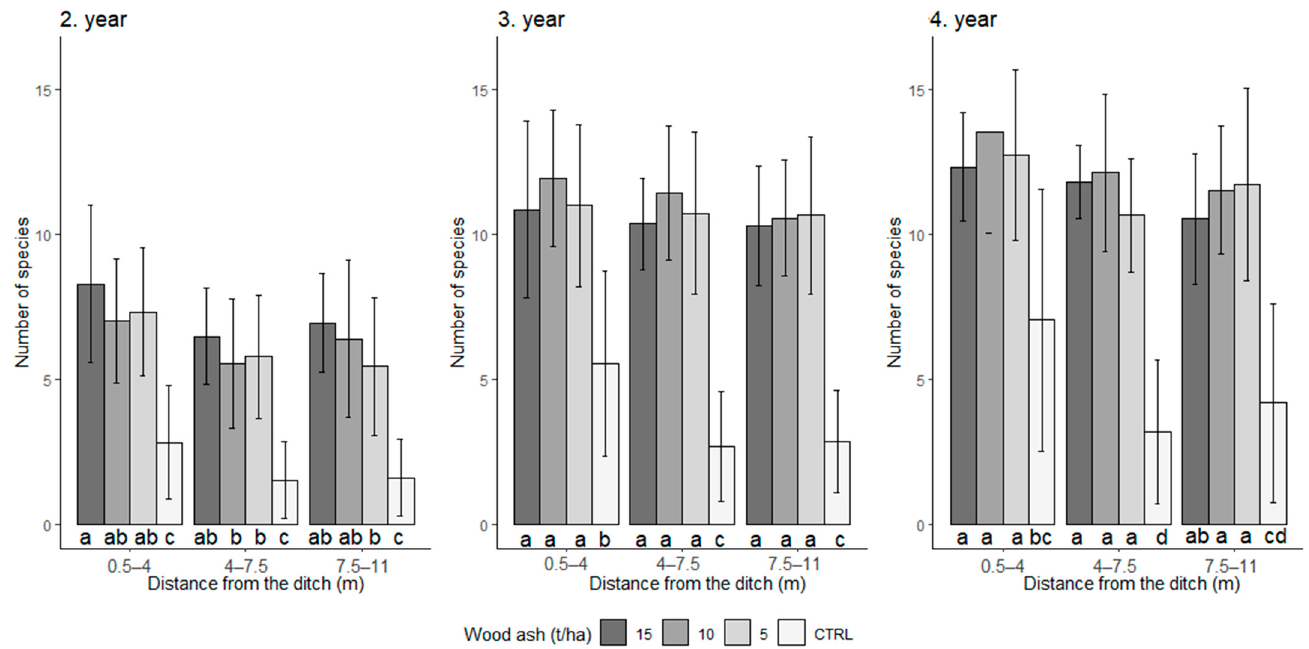
Figure 3. Species richness depending on the distance from the drainage ditch and wood-ash fertiliser dose during second to fourth vegetation season following the application of fertiliser. Different letters (a, b, c, d) indicate significant differences between groups, p < 0.05 according to the Tukey HSD test. Error bars represent standard deviation.